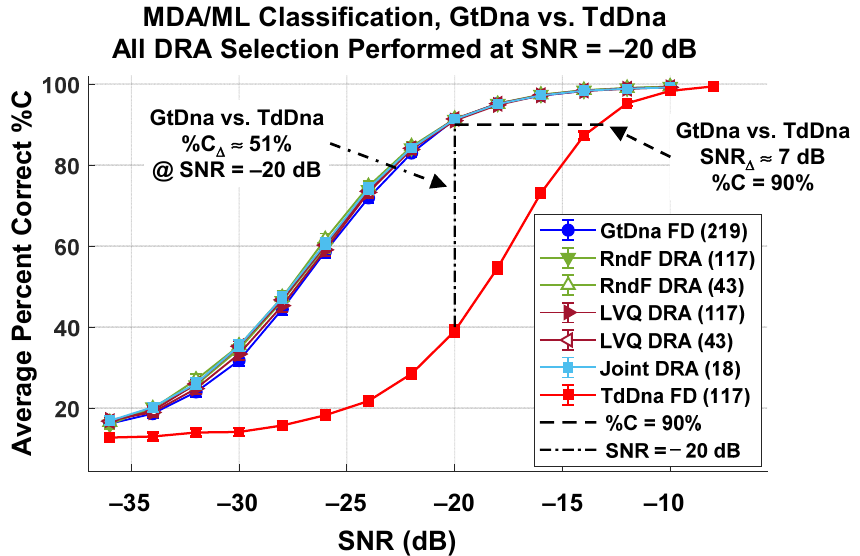
Figure 10. Composite MDA/ML classification performance for N Cls = 8 devices using indicated feature sets. GtDna feature improvement is indicated by an SNR Δ = SNR GT − SNR TD ≈ 7 dB “gain” at %C ≈ 90% and %C Δ = %C GT − %C TD ≈ 51% improvement at SNR = − 20 dB.